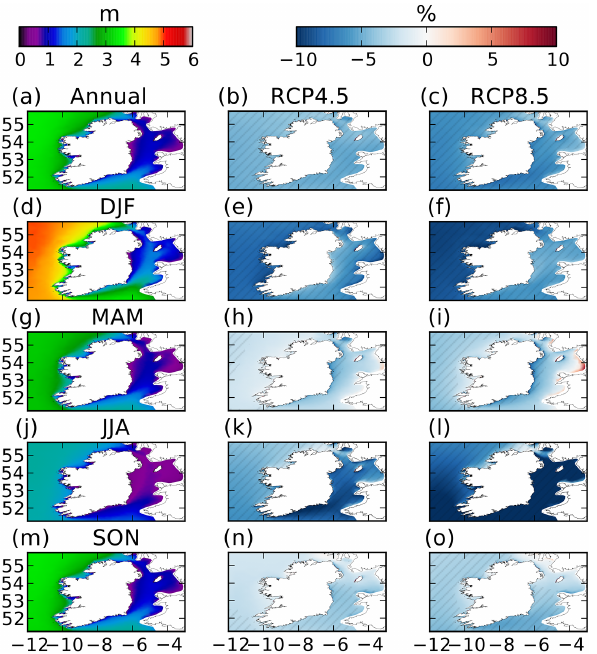
Figure 4. Ensemble mean SWH (m): (a) annual (d) DJF (g) MAM (j) JJA and (m) SON for the historical period (1980–2009). Pro- jected changes (%) in annual ensemble mean SWH for the pe- riod 2070–2099 relative to 1980–2009 for ensemble mean RCP4.5: (b) annual (e) DJF (h) MAM (k) JJA (n) SON and ensemble mean RCP8.5: (c) annual (f) DJF (i) MAM (l) JJA and (o) SON. Hatching denotes areas where the magnitude of the ensemble mean change exceeds twice the inter-model standard